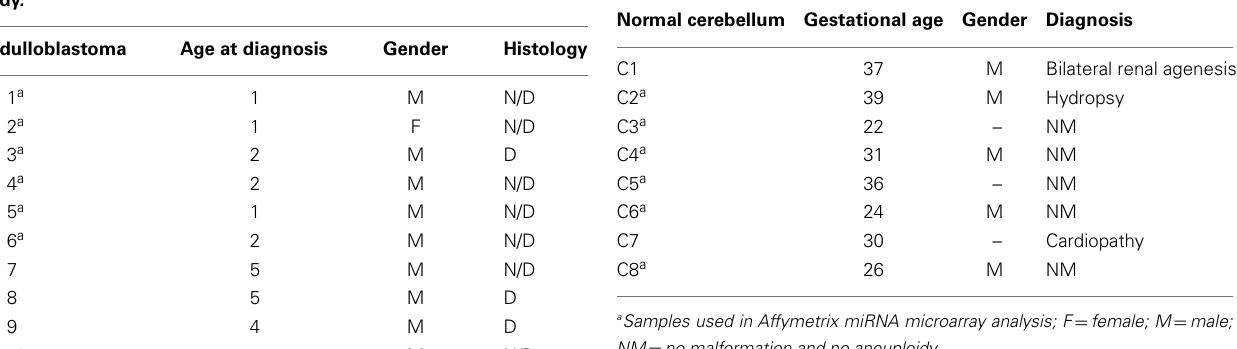
Table 1 | Summary of the medulloblastoma samples included in the study.